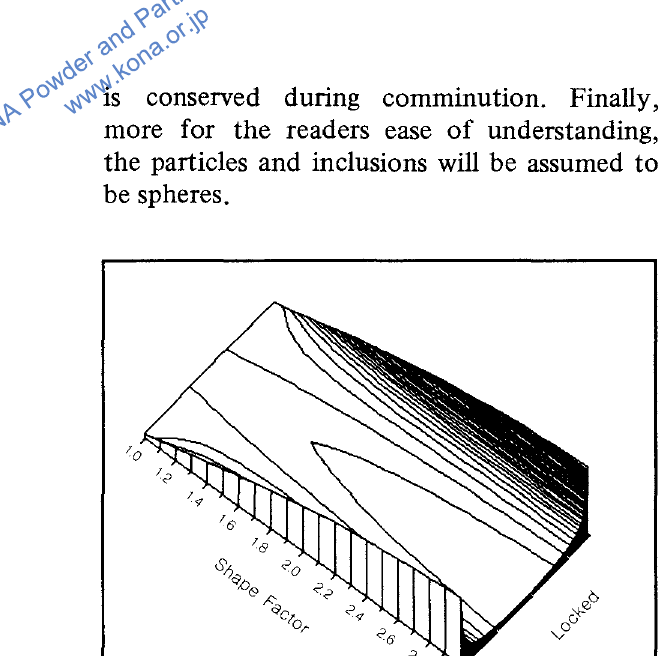
Fig. 3 Most small locked particles have a composition close to that of the pure